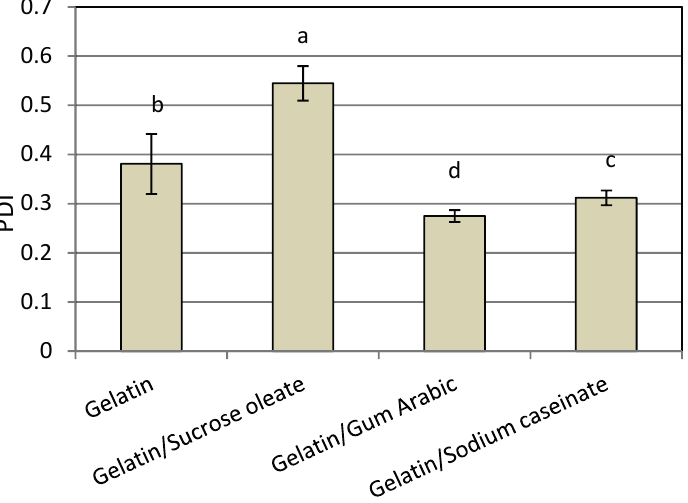
Figure 2. Mean PDI of freshly prepared astaxanthin nanodispersions stabilized with different gelatin-based emulsifying systems.